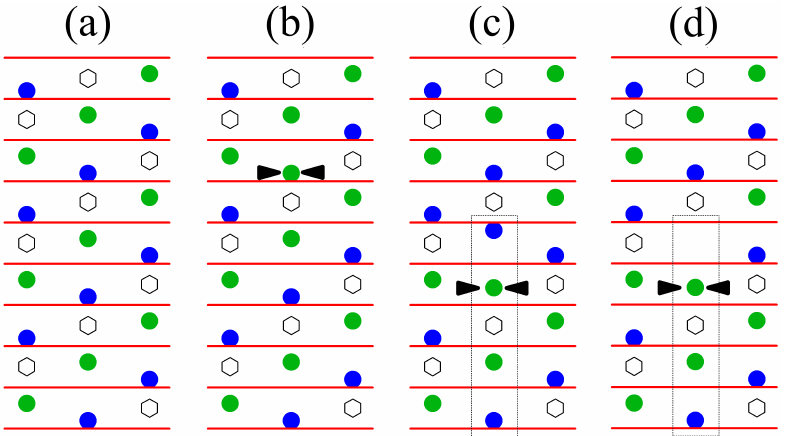
Figure 2. Stacking models for the intrinsic defect structure of LiNbO 3 : ( a ) regular stacking, ( b ) Nb- antisites (extra Nb indicated by arrows), ( c ) ilmenite stacking faults (boxed area) and ( d ) as ( c ) but with Li vacancy (acts like a Nb-antisite). Nb is represented by green, Li by blue and free octahedral positions by white symbols, and the oxygen layers are depicted as red lines (from